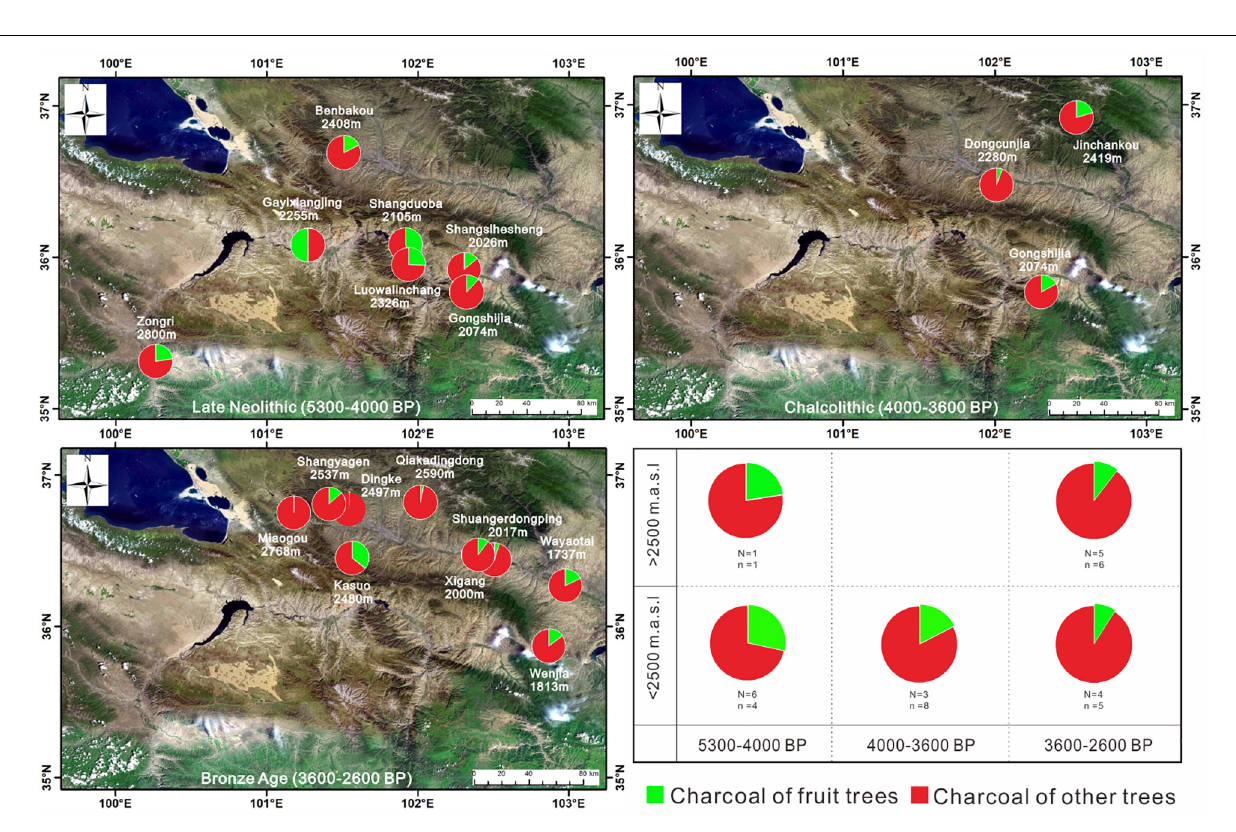
Frontiers in Plant Science |